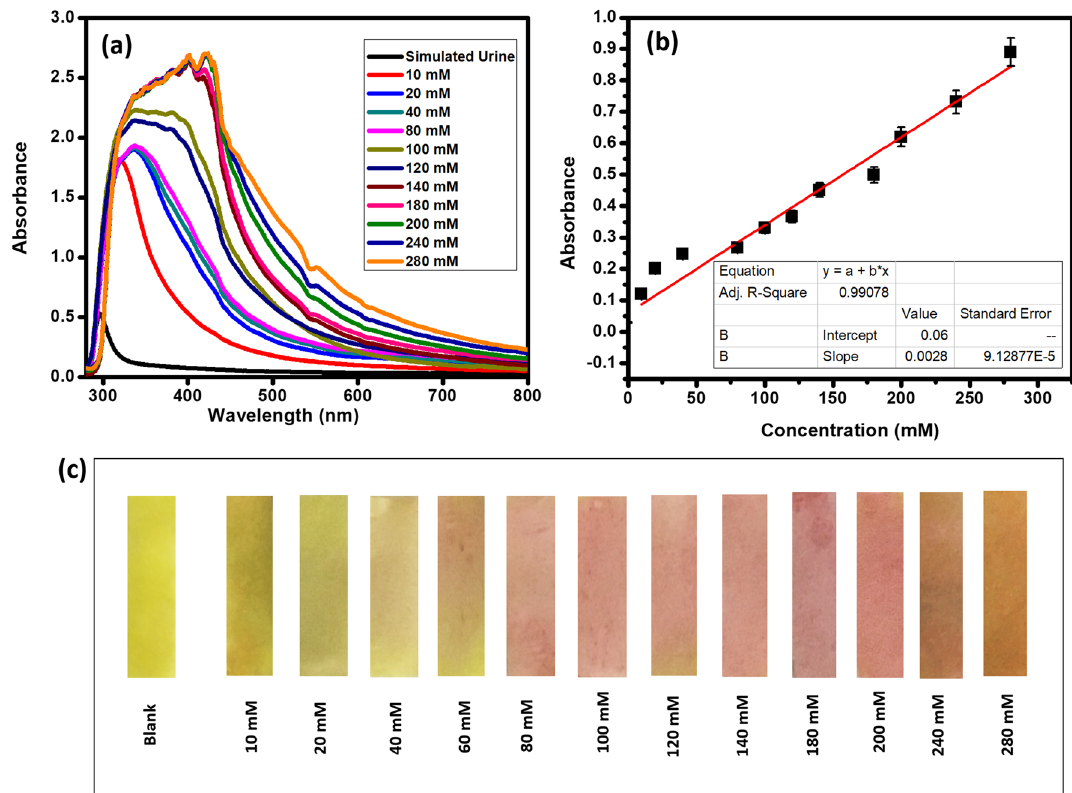
Figure 8. ( a ) Absorbance profile of simulated urine samples upon the addition of CuC. ( b ) Linear responses of absorbance changes with respect to the concentration of Na + in the simulated urine samples. ( c ) Photograph of CuC-test strips with different concentrations of Na + containing urine samples. Error bars represent standard error of the mean (n =